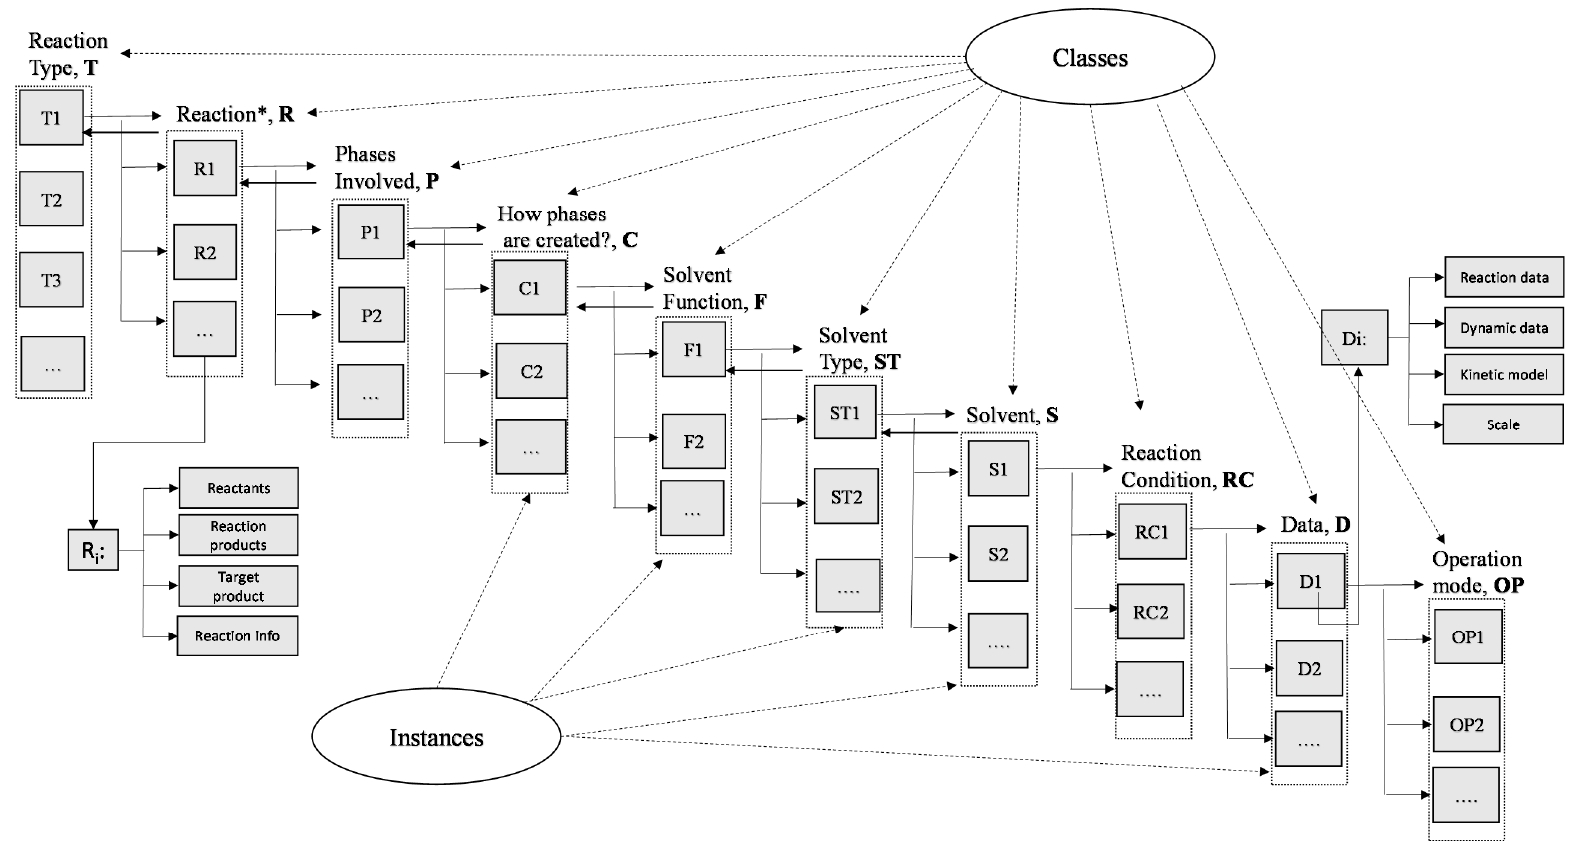
Figure 2. Knowledge representation system of the reaction database.